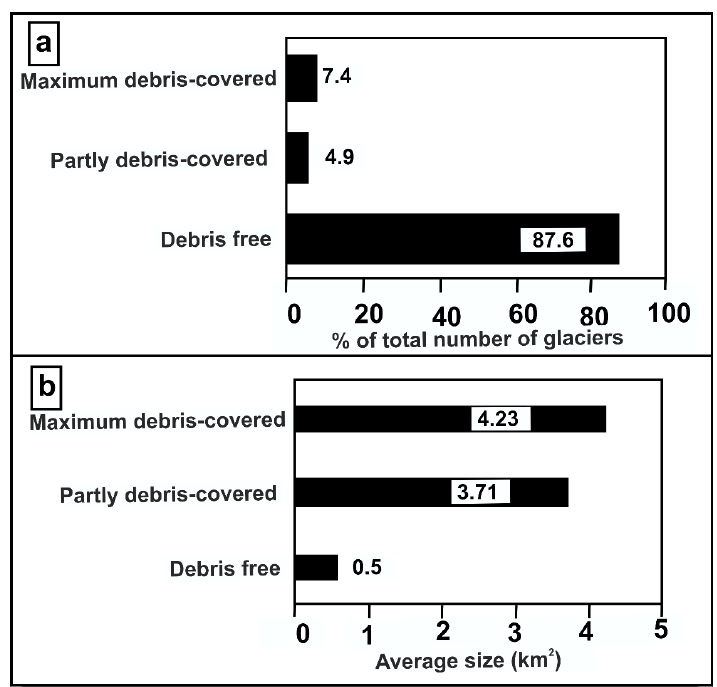
Figure 9. Division of glaciers according to debris cover in the ablation zone; ( a ) frequency distribution (in percentage) of glaciers according to type (excluding the rock glaciers), ( b ) proportion of area according to the glacier type.